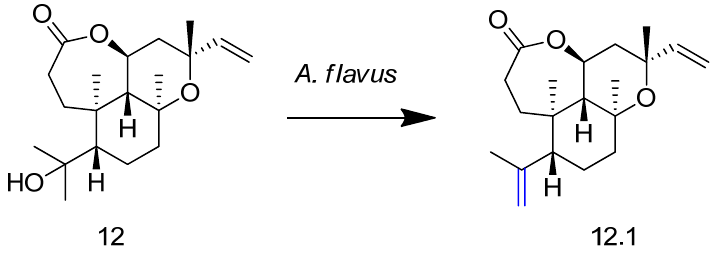
Figure 13. Biotransformation of agallochaexcoerin A ( 12 ) in agallochaexcoerin G ( 12.1 ) by Aspergillus flavus [58].